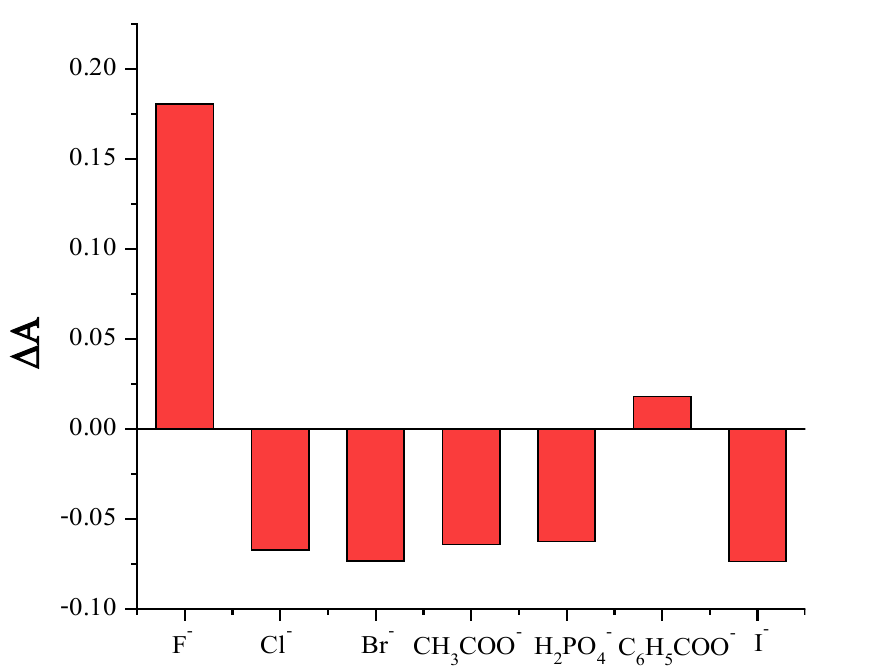
Figure 6. Bar graph of absorbances at 310 nm for different mixtures of sensor R1 with various anions.